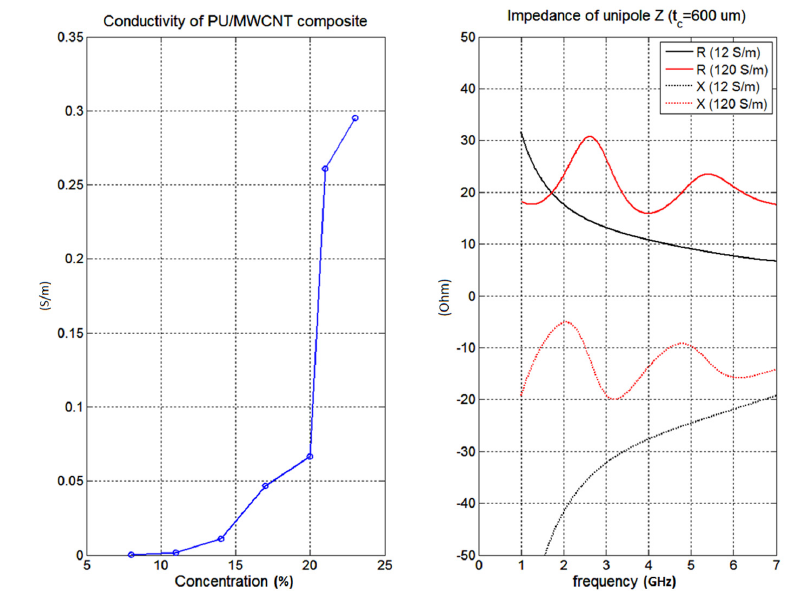
Figure 6. Left (Conductivity of PU/MWCNT composite versus concentration of CNTs), Right (Impedance of unipole antenna).